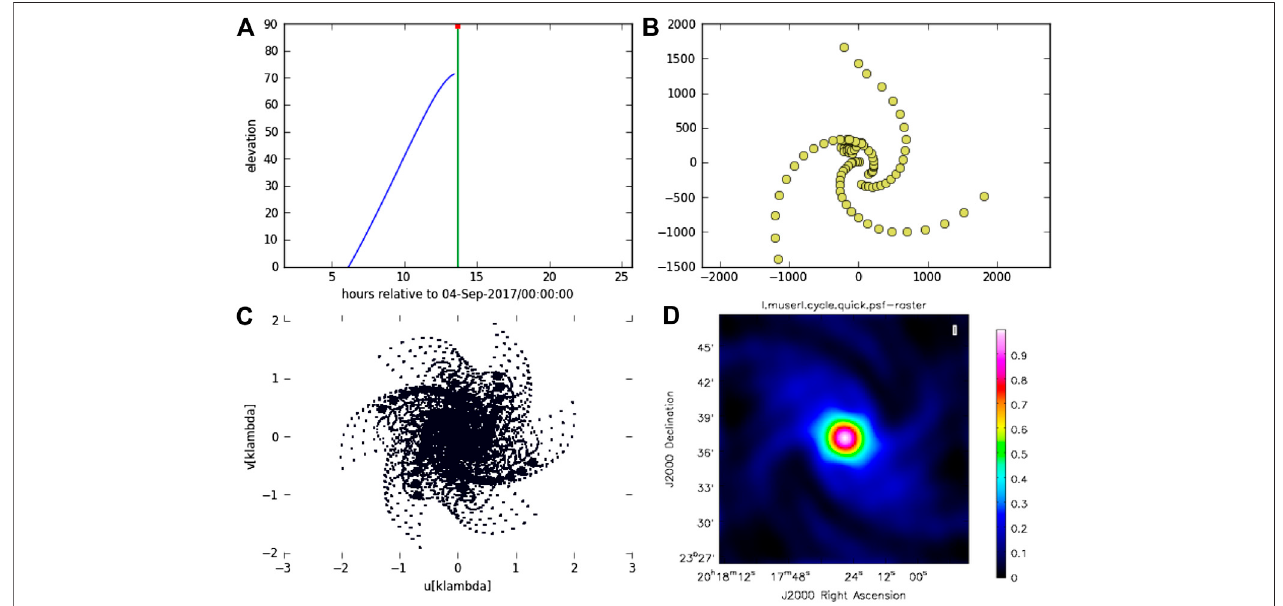
FIGURE 11 | (A) The hour angle and declination of the Sun on September 2017. (B) The 100 LPDA locations of MUSER extension to 30 – 400 MHz. (C) The snapshot uv distribution at 200 MHz. (D) The synthesized beam at 200 MHz.